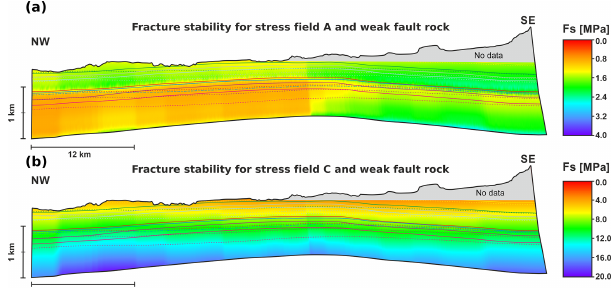
Figure 8. Fracture stability plotted onto the Coyote Wash Fault sur- face for (a) stress field A and a low-friction fault rock and (b) stress field C and a low-friction fault rock. Note the differences in the colour scale. F s is more critical in the NW part of the fault for stress field A, while F s for stress field C is far from critical. Dashed lines represent the hangingwall, and straight lines represent the footwall cut-off lines; see Fig. 5 for stratigraphic